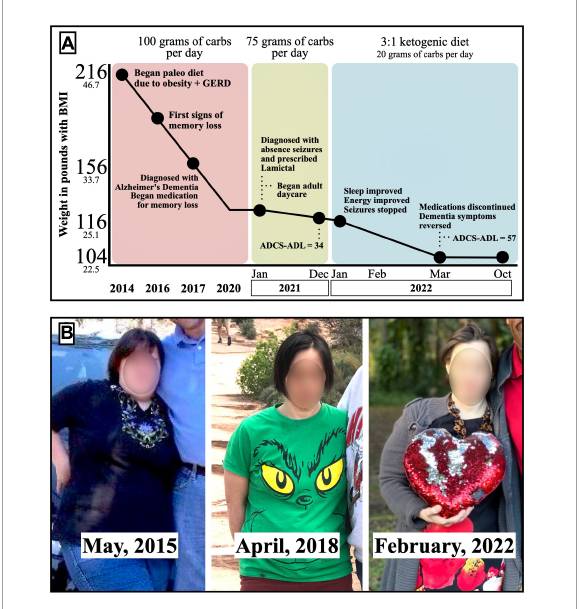
FIGURE1 (A) Timeline of Mary’s dietary patterns, weight loss, clinical symptoms, and ADCS-ADL scores. (B) Photos of Mary during the different dietary